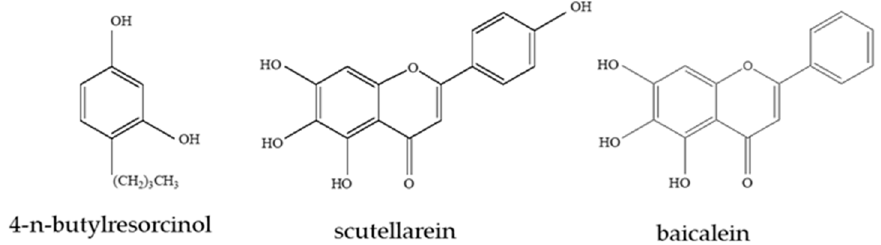
Figure 1. The chemical structure of 4-n-butylresorcinol, scutellarein [5,6,7-trihydroxy-2-(4-hydroxyphenyl)-chromen-4-one] and baicalein (5,6,7-trihydroxy-2-phenyl-chromen-4-one) derived from Scutellaria baicalensis Georgi (SBG).